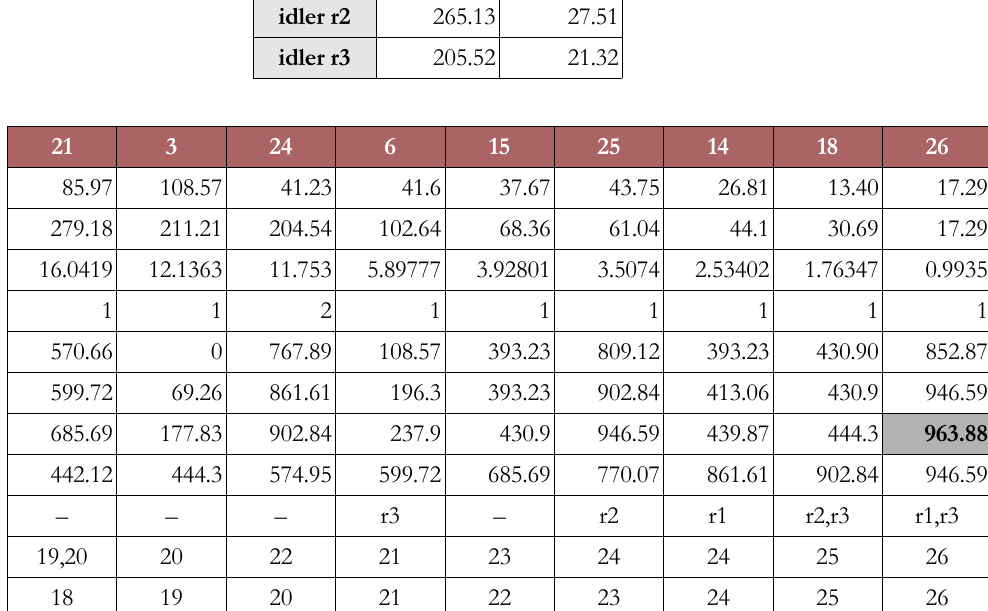
Table 13. ACTRES Scheduling, Rmax = 2, n(r) = 3 (Scenario